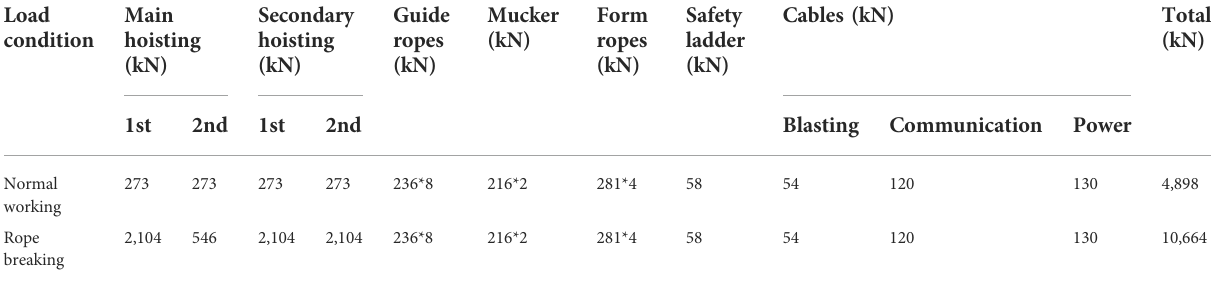
TABLE 2 Loads applied to the SA-3 shaft sinking headframe under normal working